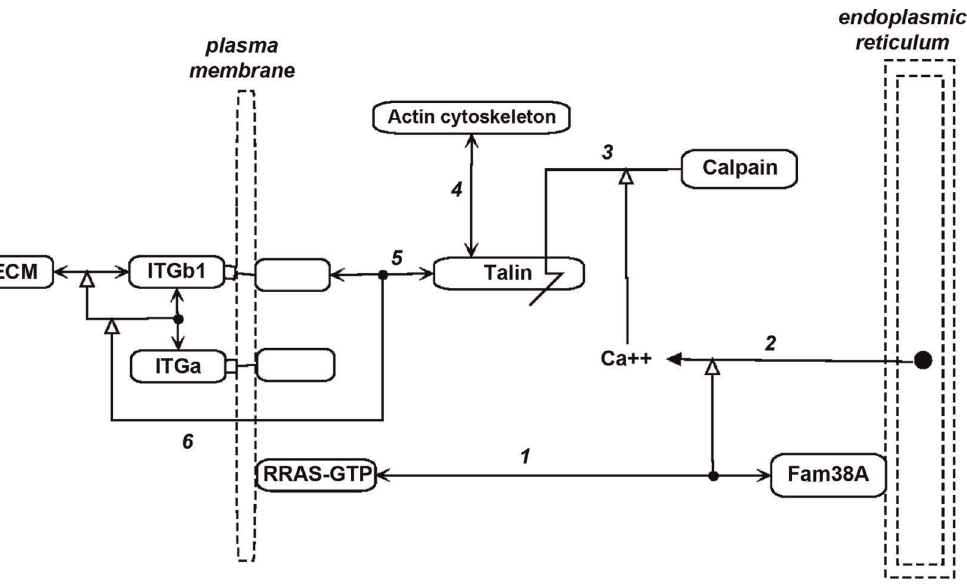
Figure 8. Molecular interaction map (MIM) of the role of RRAS and calcium in the regulation of linkage between integrins and actin cytoskeleton, as proposed by McHugh et al [ 20 ] . ECM, extracellular matrix.